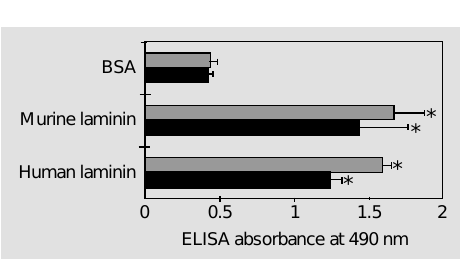
Figure 1 - Adhesion of S. schen- ckii yeast cells (A) and conidia (B) to immobilized fibronectin, thrombospondin and fibrinogen at 10 µg/ml compared to adhe- sion to BSA. Values were sub- tracted from the negative con- trol (poly-HEMA). S . schenckii adhesion (10 7 cells/well) was as- sessed by ELISA with an anti- S. schenckii antiserum *P<0.05 compared to BSA (Student t -test).